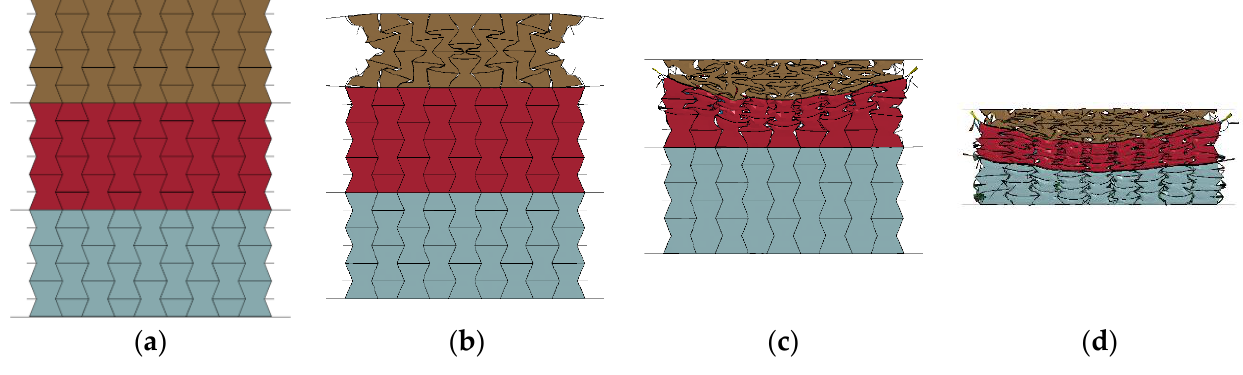
Figure 17. The response modes of foam concrete-filled auxetic honeycombs ( t = 0.2:0.2:0.2 and ρ = 408:575:848) at different compression strokes (1 m/s): ( a ) D = 0 mm; ( b ) D = 15 mm; ( c ) D = 55 mm; ( d ) D = 95 mm.